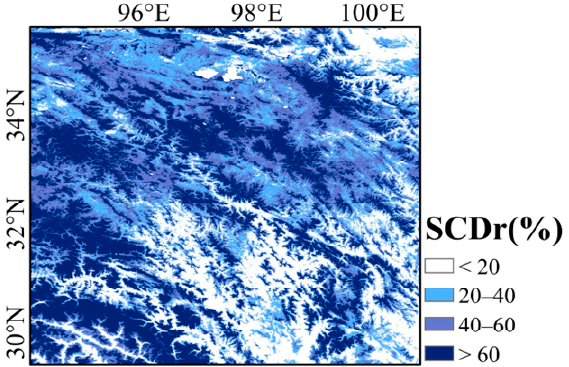
Figure 6. The derived SCDr map in the study area. SCDr is the ratio of days with snow to total days from DOY 001 to DOY 208.